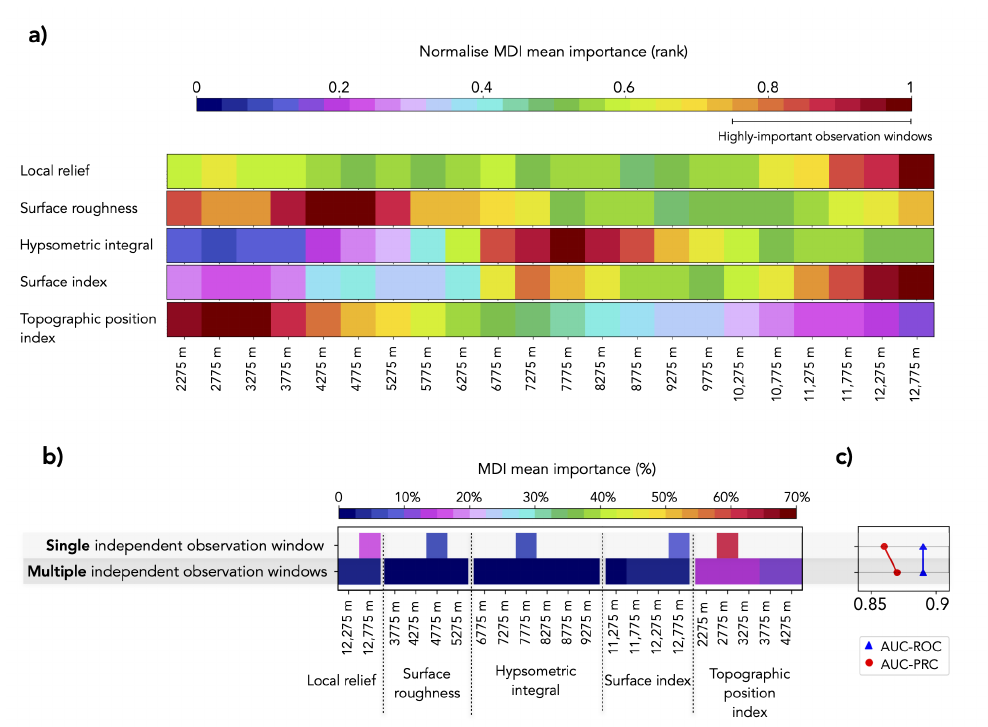
Figure 6. MDI importance ranking, which includes a variety of observation window sizes for each window-based morpho- metric index and landslide susceptibility models that include the window-based morphometric indices calculated with highly-informative, independent observation windows. The first model includes the single, most important window size for each window-based morphometric index. The second model includes the window-based morphometric index calculated with multiple, highly-important, independent observation windows. To select a range of observation windows with a strong impact on the results, we set a threshold of 75% on the normalized MDI importance ranking. ( a ) Normalized MDI mean importance ranking of each morphometric index. ( b ) MDI mean importance for the predictive variables that were included in the models. ( c ) Evaluation metrics: mean area under the receiver operator curve (AUC-ROC) and mean area under the precision-recall curve (AUC-PRC) from 50 iterations of the same model while using a random selection of the training